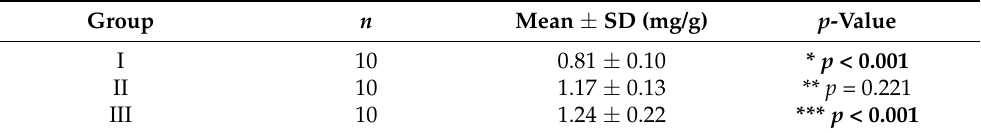
Table 3. Fluoride content in tooth enamel in groups with different stages of fluorosis. Group n